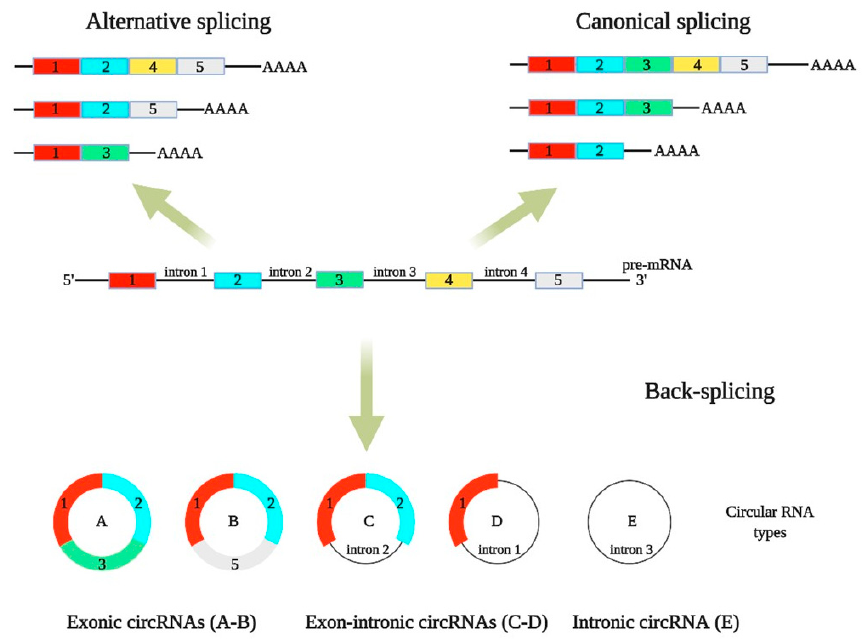
Figure 1. Biogenesis and diversity of circRNAs. CircRNAs are produced by a splicing process known as back-splicing. ( A , B ) Exonic circRNAs are derived from exons, ( C , D ) exon-intronic circRNAs are derived from both exons and introns, and ( E ) intronic circRNAs are derived from introns.